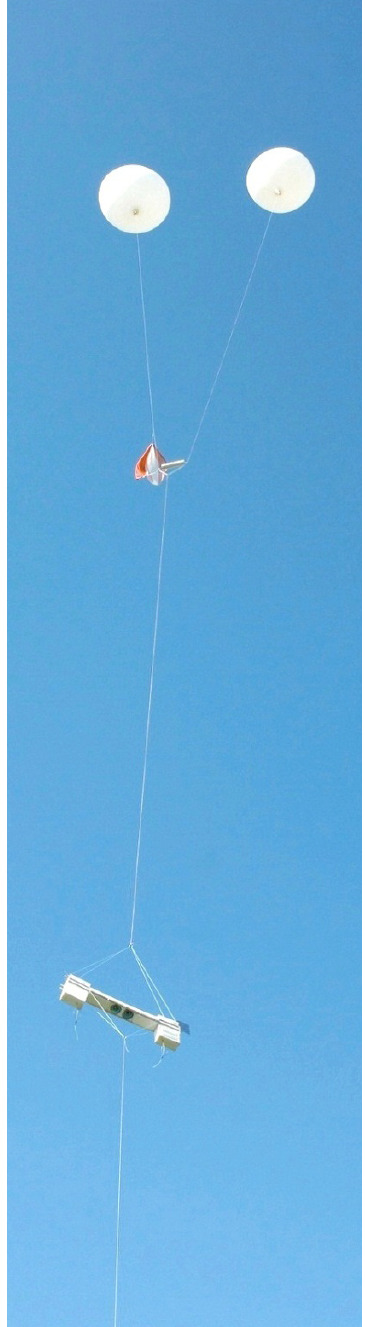
Figure 8. Flight configuration for the double balloon method. Each of the two balloons and payload are attached to a vertex of a triangu- lar aluminium frame outfitted with the Intelligent Balloon Release Unit that releases the carrier balloon at a preset altitude. The config- uration is shown attached to the launching pole just prior to